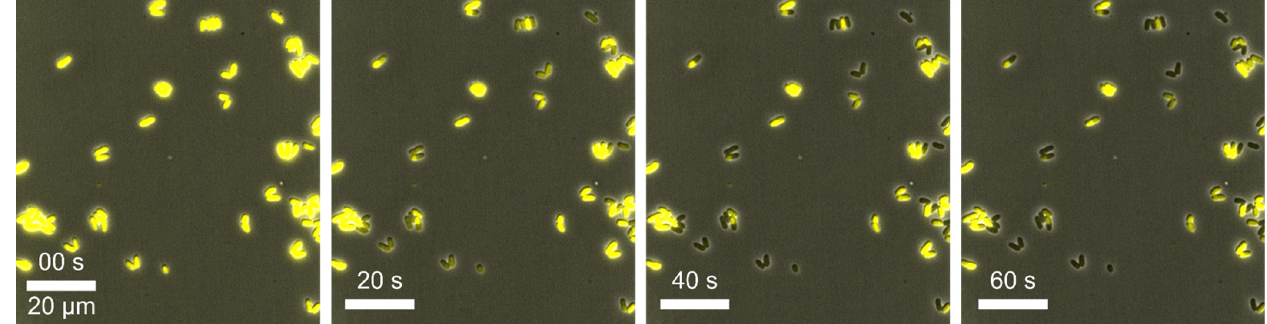
Figure 10. Microscopic images of C. glutamicum DM1800 pSenLysTK in which cell death of cells occurs by photobleaching at a fluorescence intensity of 100% and exposure time of 100 ms (scale bar = 20 μ m).